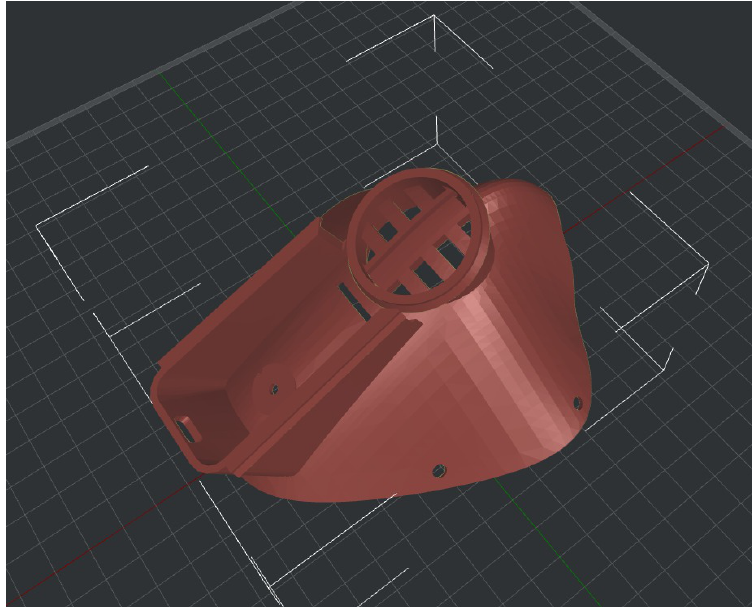
Figure 2. 3D Model Design of (ME) 2 innovative